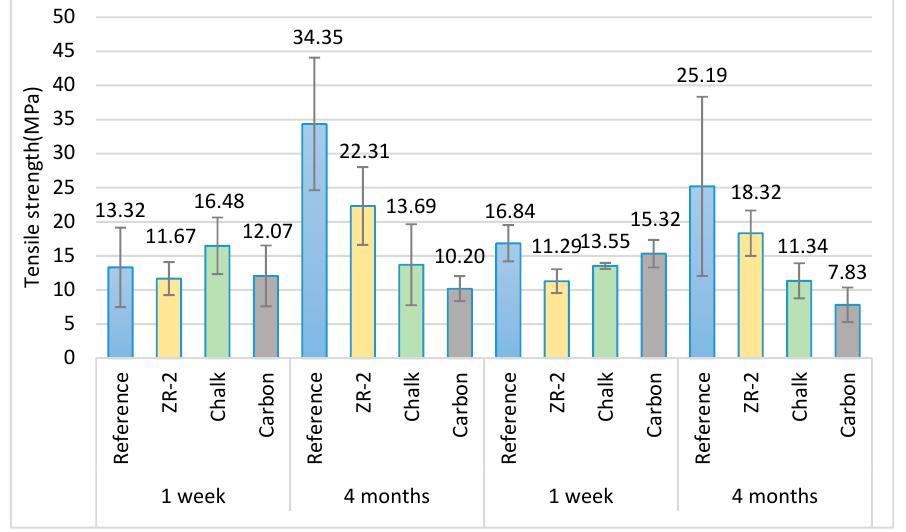
Figure 11. Strength test results of the adhesive compositions subjected to tests.